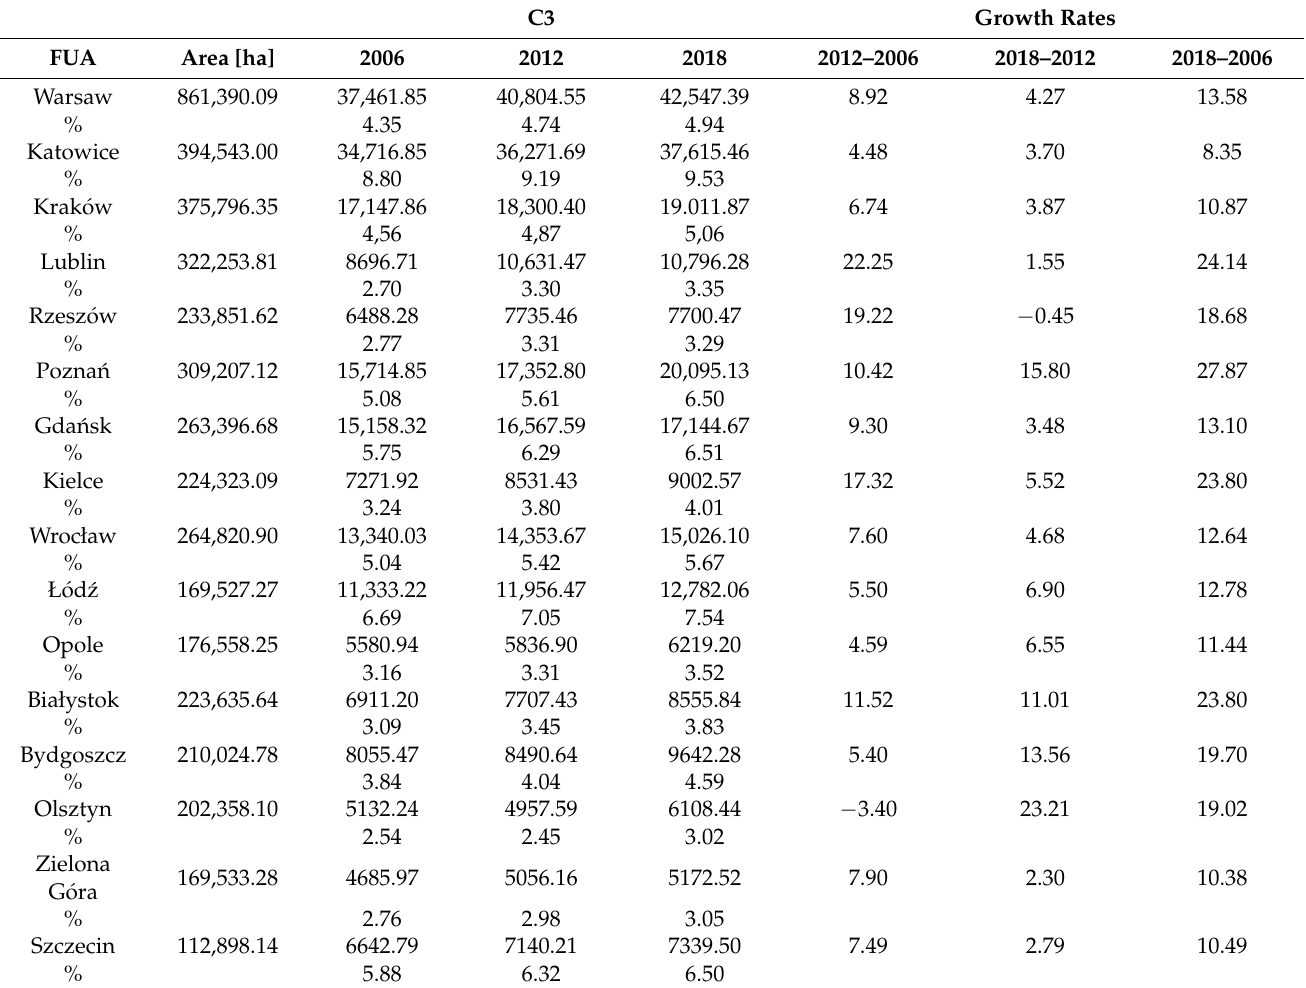
Table 5. C3 area [ha] in each investigated area in 2006, 2012, and 2018. C3 Growth